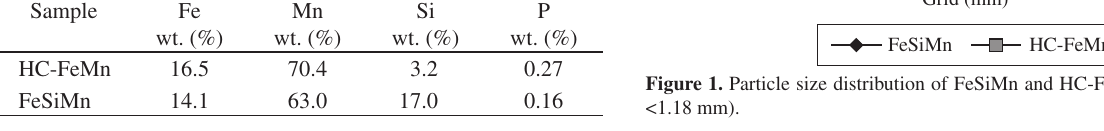
Table 2. Chemical analysis of manganese alloys fines below 1.18 mm. Sample